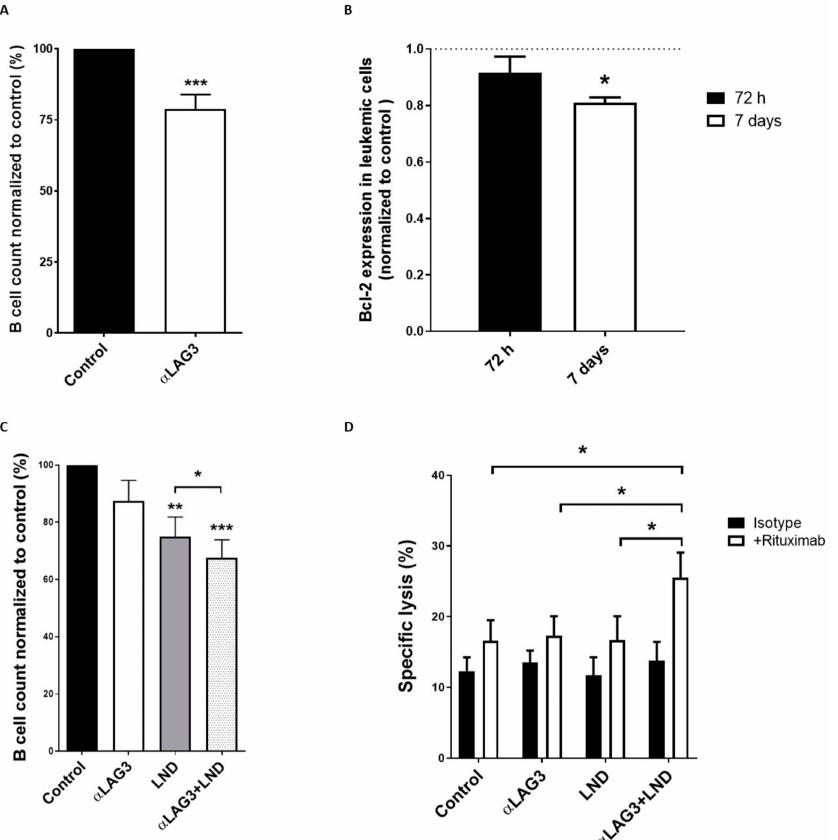
Figure 5. Treatment with relatlimab depletes leukemic cells. ( A ) PBMCs from 26 patients with CLL were treated with relatlimab or isotype control (10 µ g/mL) and absolute leukemic cell count was performed at indicated timepoints. Bars represent the percentage of leukemic cells normalized to control; ( B ) Intracellular staining and flow cytometry analysis for Bcl-2 expression (normalized to control) were performed in PBMCs treated with relatlimab or isotype control (10 µ g/mL) for 72 h or 7 days ( n = 8); ( C ) Evaluation of absolute leukemic cell count (normalized to control) in PBMCs from patients treated with relatlimab or isotype control (10 µ g/mL), alone or in combination with lenalidomide (LND) (10 µ M), for 72 h ( n = 12); ( D ) Effect of LAG-3 blockade on NK cell-mediated cytotoxicity was evaluated by calcein-AM assay in PBMCs from 10 patients treated with relatlimab (10 µ g/mL), alone or in combination with lenalidomide (LND; 10 µ M), and co-cultured with MEC-I CLL-derived cell line at 25:1 (E:T) ratio ( n = 10) for 72 h. ADCC was evaluated by pre-treating target MEC-I cells with rituximab (10 µ g/mL). * p < 0.05, ** p < 0.01 and *** p <